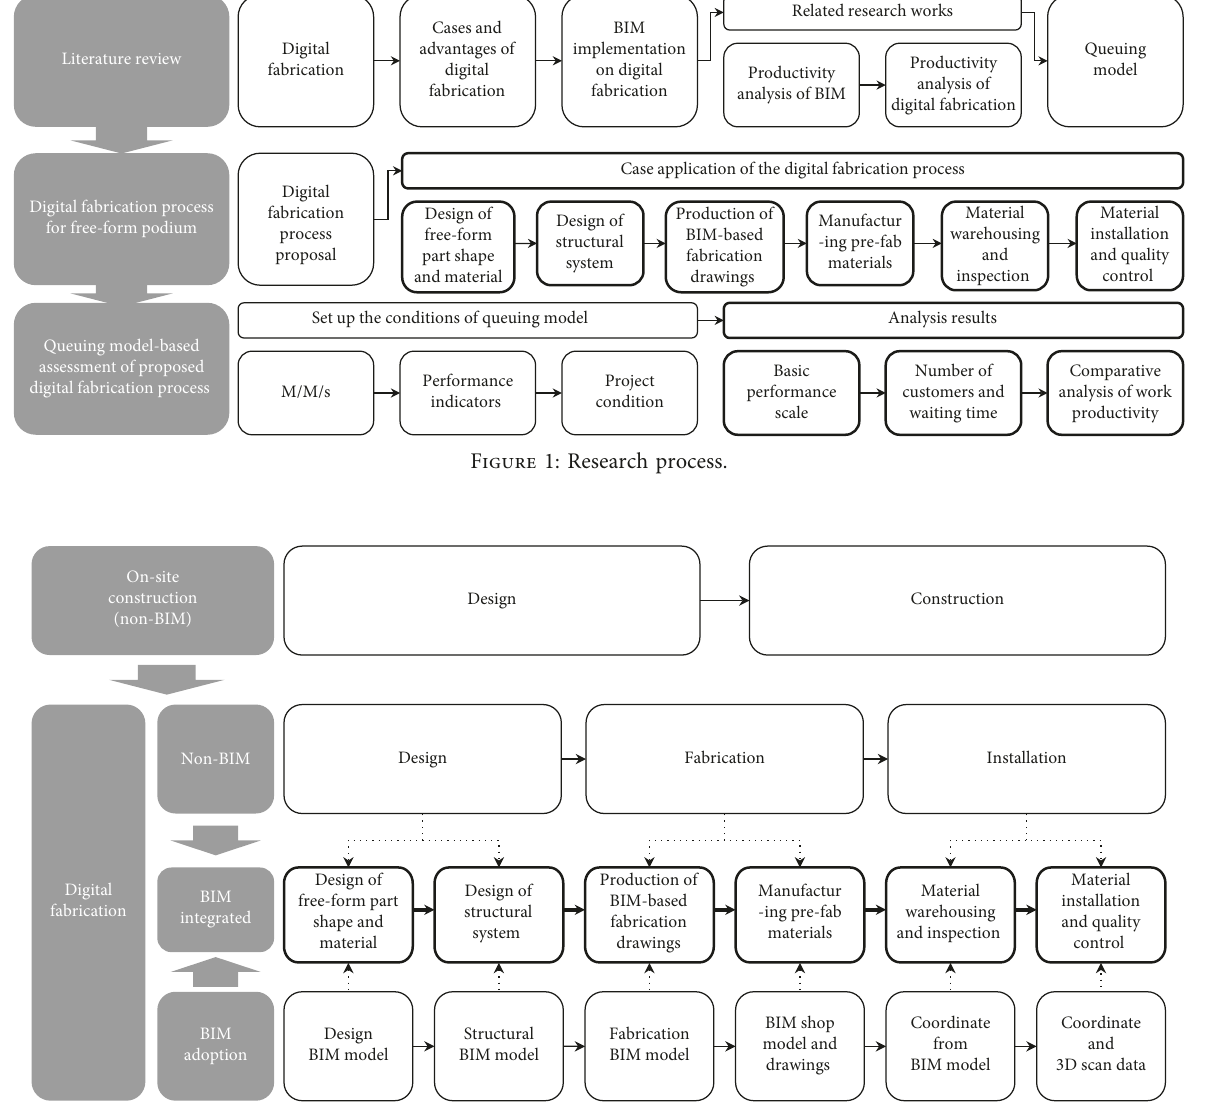
Figure 2: Proposed digital fabrication process.